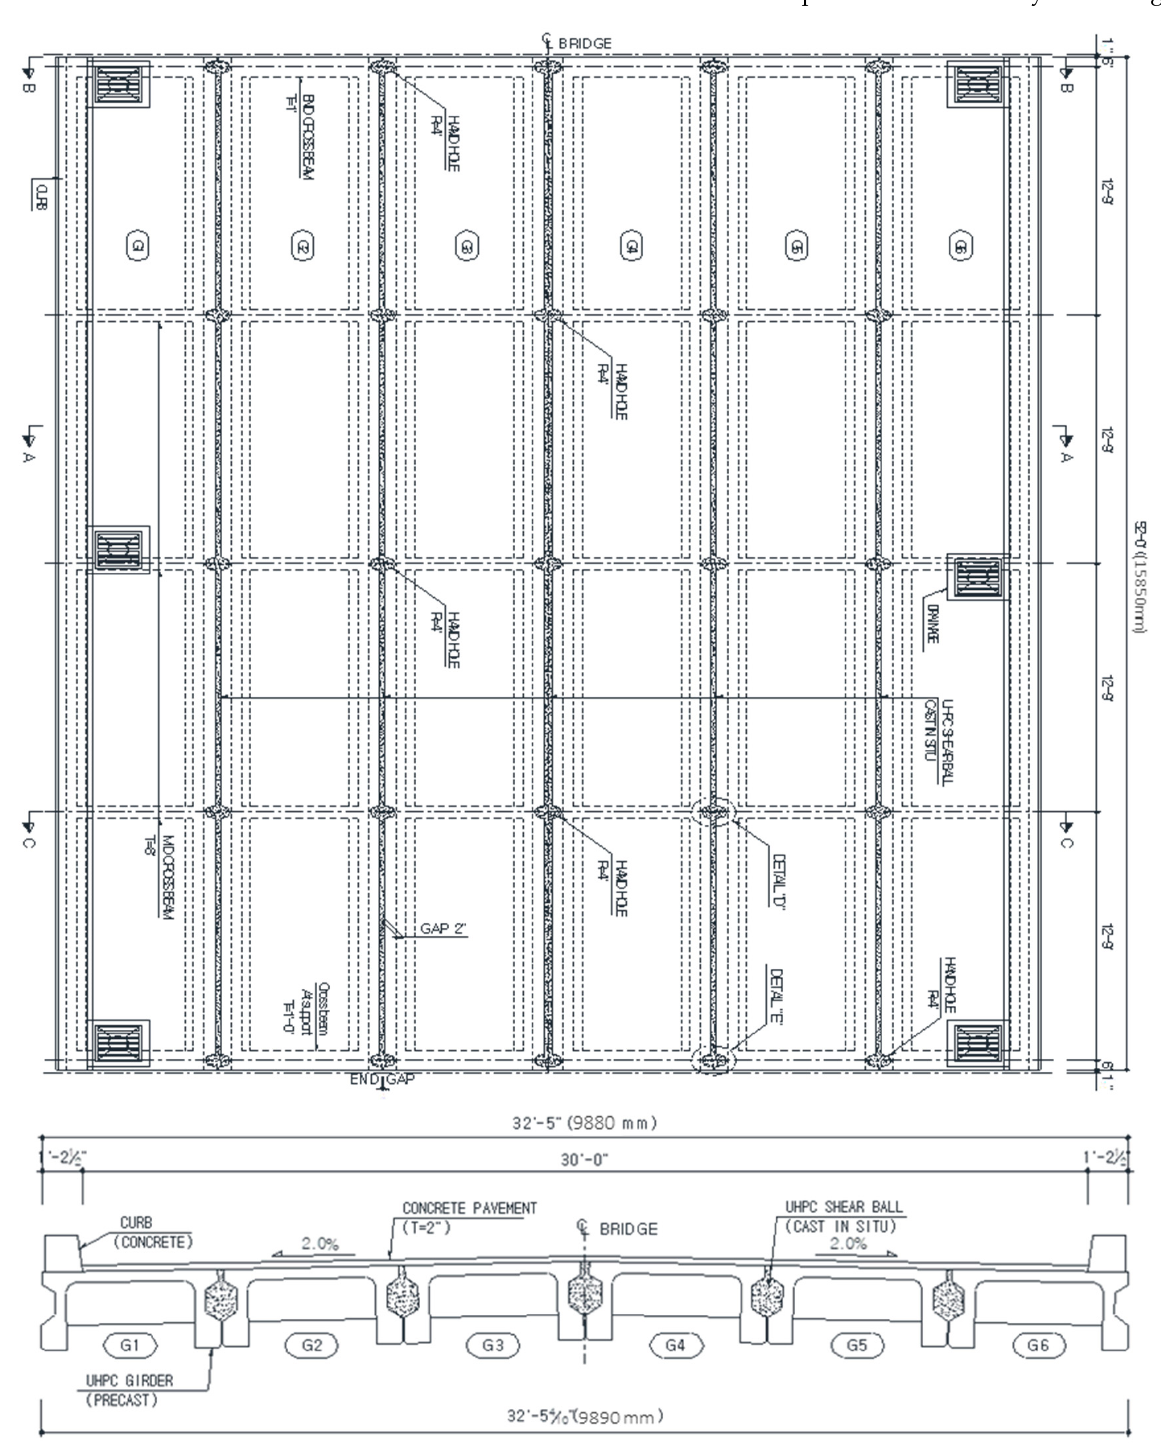
Figure 5. Plan view and cross-section of Hawkeye Bridge design.